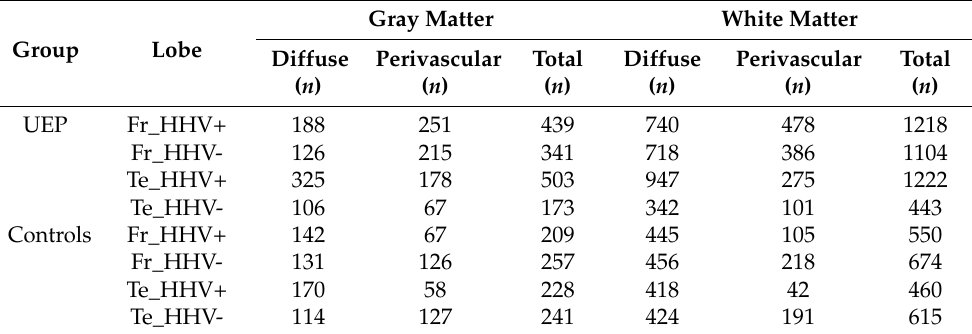
Table 5. An arrangement of the total number of CD68 positive cells in the frontal and temporal lobes of UEP individuals and control group comparing herpesvirus (HHV) PCR+ with HHV PCR- tissue